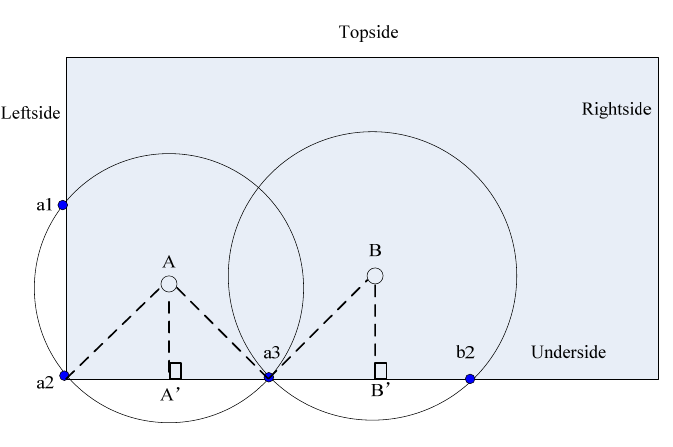
Figure 10. Illustration of radio radius